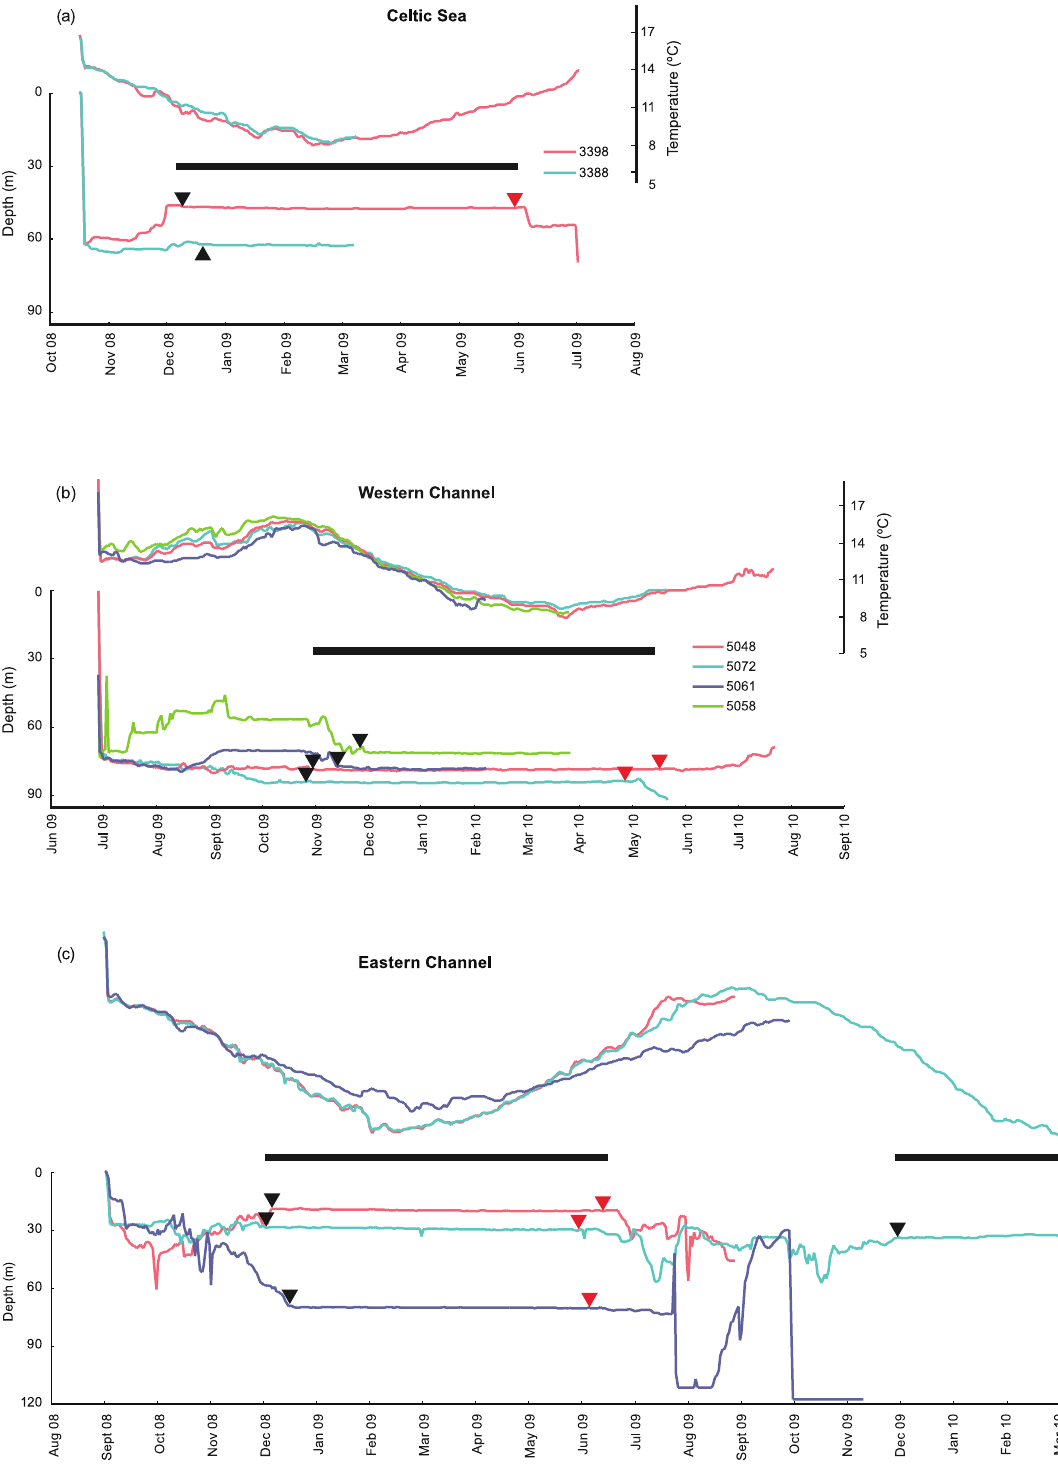
Figure 4. Seasonal depth and temperature experience of individual crabs. Individual temperature (upper plot) and depth (lower plot) records for edible crabs tagged with electronic data storage tags and released in the a) Celtic Sea, b) Western Channel and c) Eastern Channel. Black triangles indicate the onset of ‘‘incubation-like’’ behaviour, red triangles indicate the end of ‘‘incubation-like’’ behaviour. The approximate duration of the egg-incubation period in each area is indicated by a black